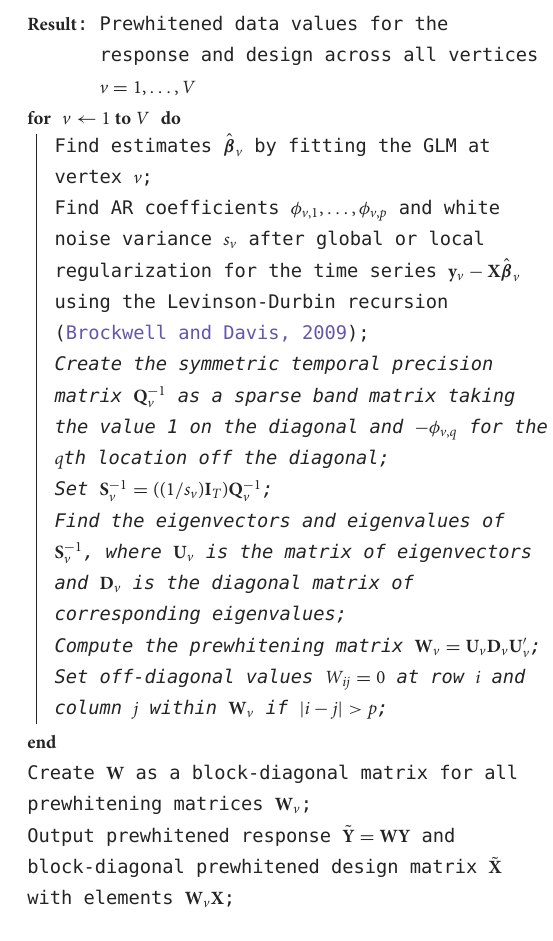
Algorithm 1. Prewhitening time series data in order to reduce temporal dependence in residuals. Steps in italics are performed using C++ for computational